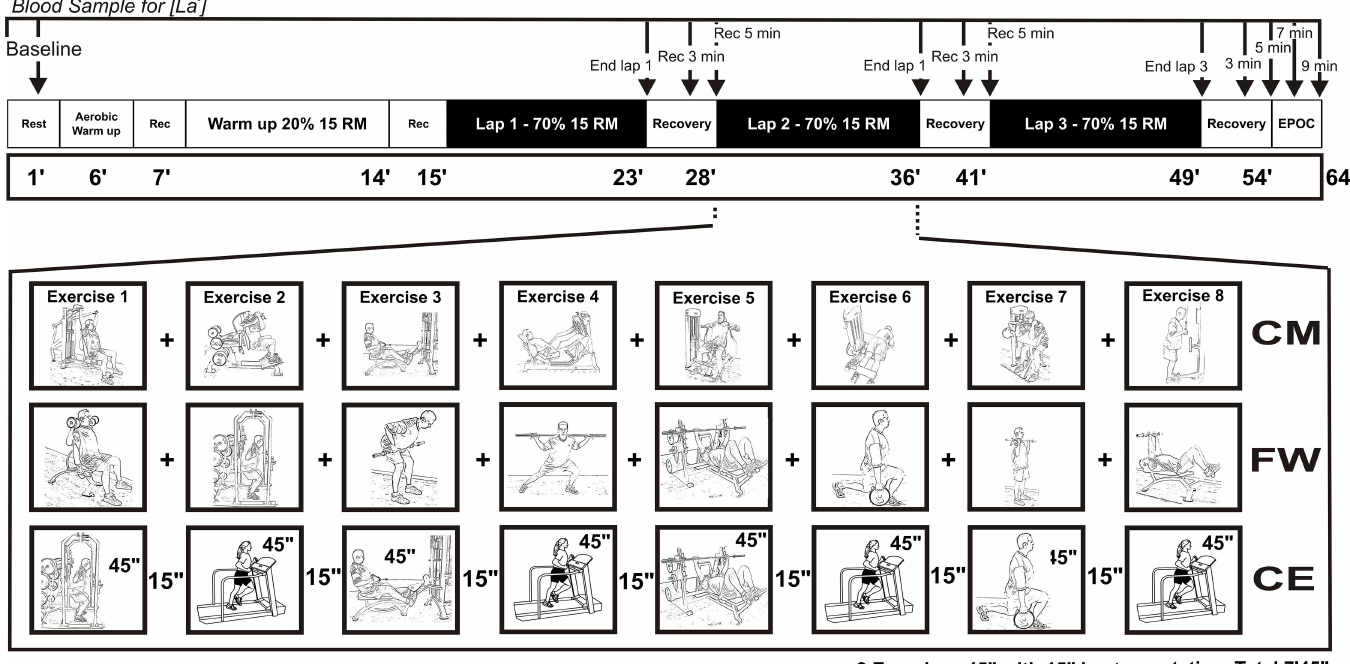
Fig 1. Exercise protocol. Circuit Machine training protocol, Free Weight-training protocol and CombinedExercise training protocol, all with the same duration, intensity, cadence, etc.